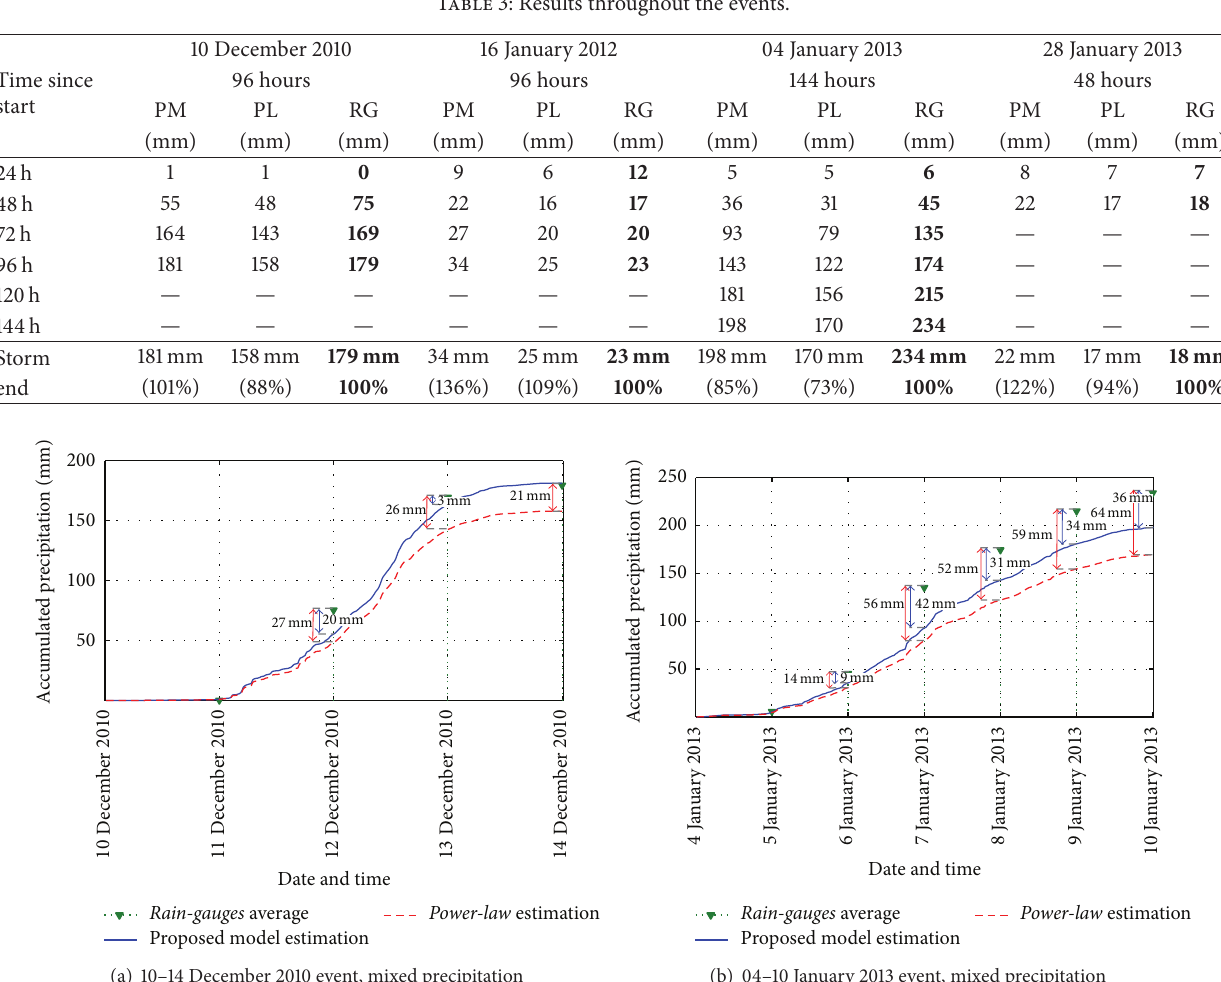
Table 3: Results throughout the events.